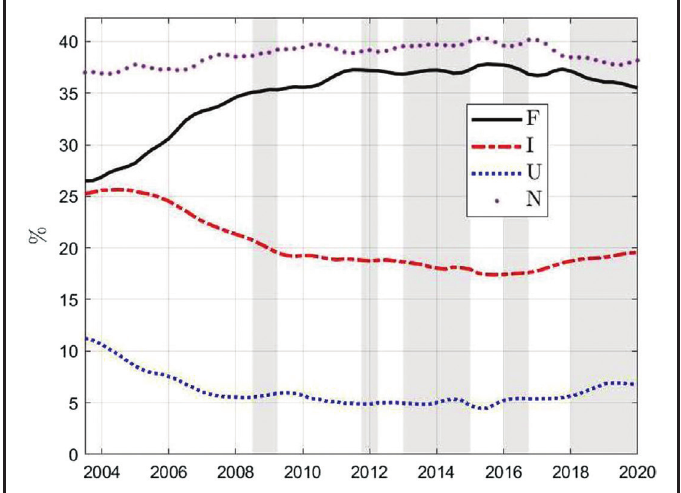
Figure 2 Labor market stocks in Argentina, in% of the working-age